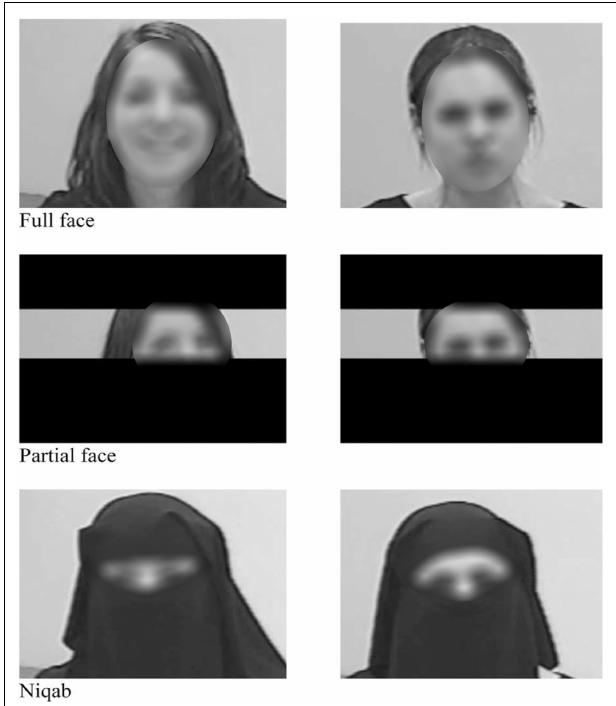
FIGURE 1 | Stills from emotion videos, full face, covered face (black bar and niqab).